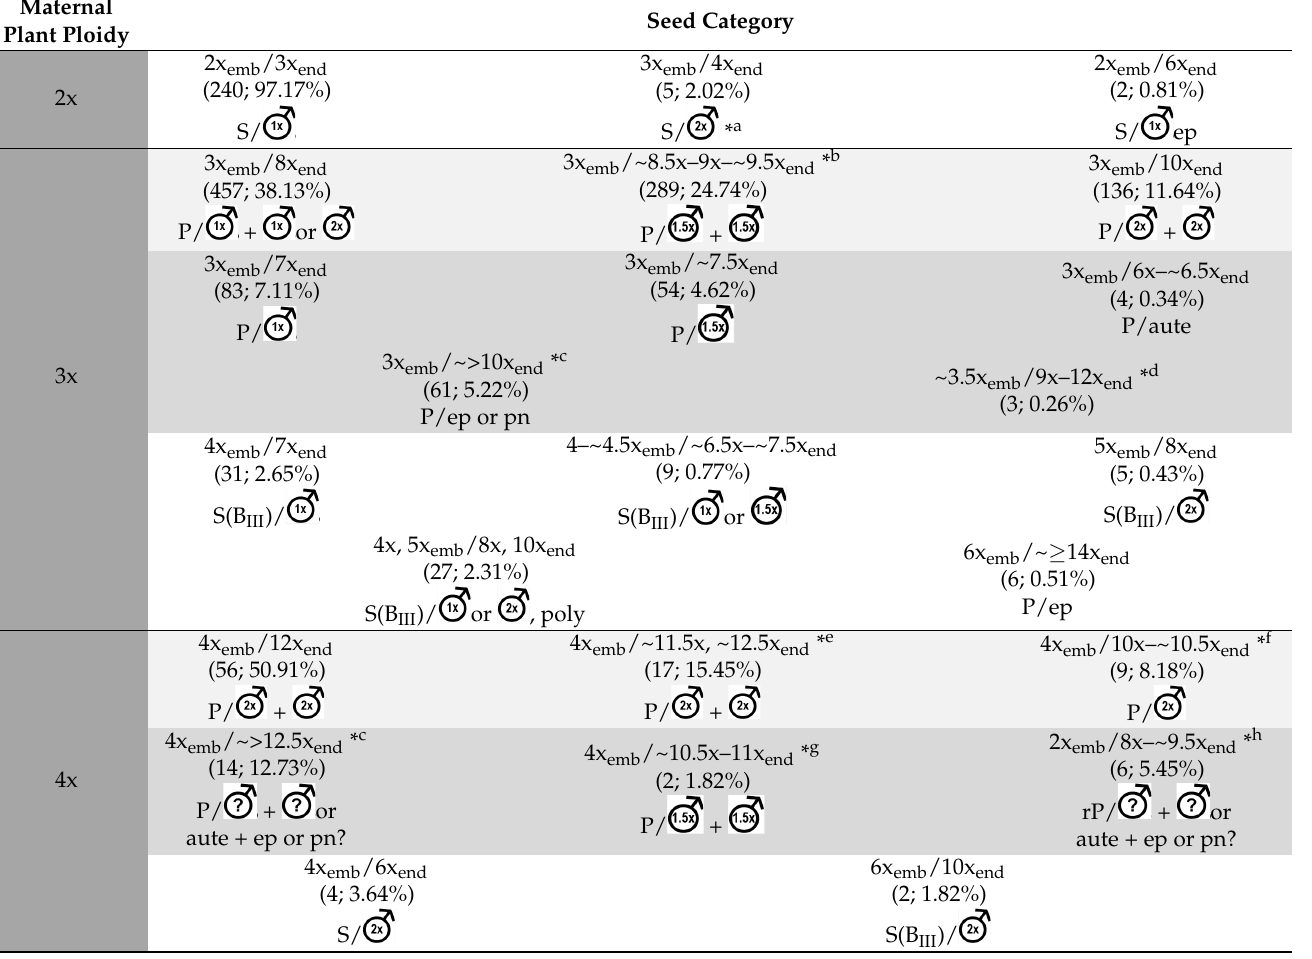
Table 3. Seed categories in Crataegus , which are described as follows: Line 1, embryo ploidy/endosperm ploidy; Line 2, number of seeds; percentage calculated from all analyzed seeds with the concerned maternal ploidy; Line 3, reproduction mode—embryo formation (S, sexual; P, parthenogenetic; B III , unreduced egg cell fertilized; rP, reduced parthenogenesis)/mode of endosperm formation (aute, autonomous endosperm; ep, endopolyploidization; ♂ , ploidy of sperm cell contributing to endosperm formation; pn, polynucleated central cell; poly, polyspermy). Note that ~1.5x ploidy level depicts highly unbalanced aneuploid reduced pollen of 3x plants, possibly of a range between 1x and 2x.